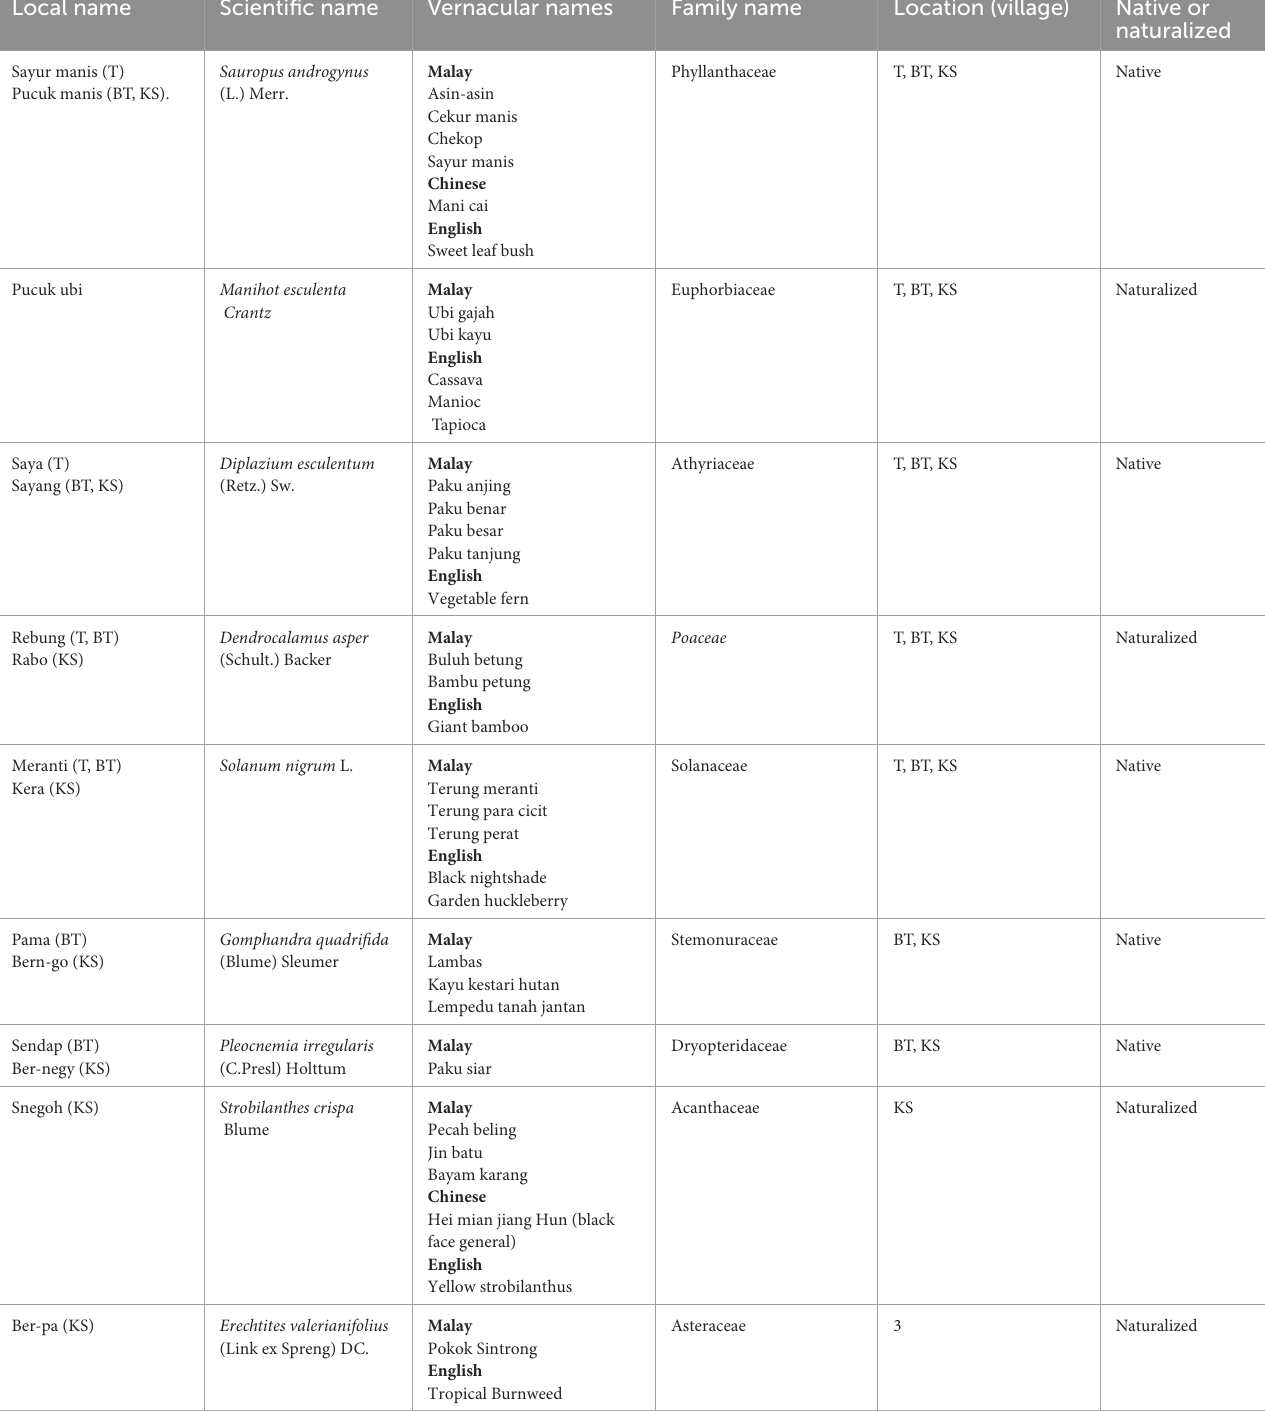
TABLE 2 Wild edible plants identified at Pos Sungai Telimau (T), Bukit Terang (BT), and Kampung Sat (KS)